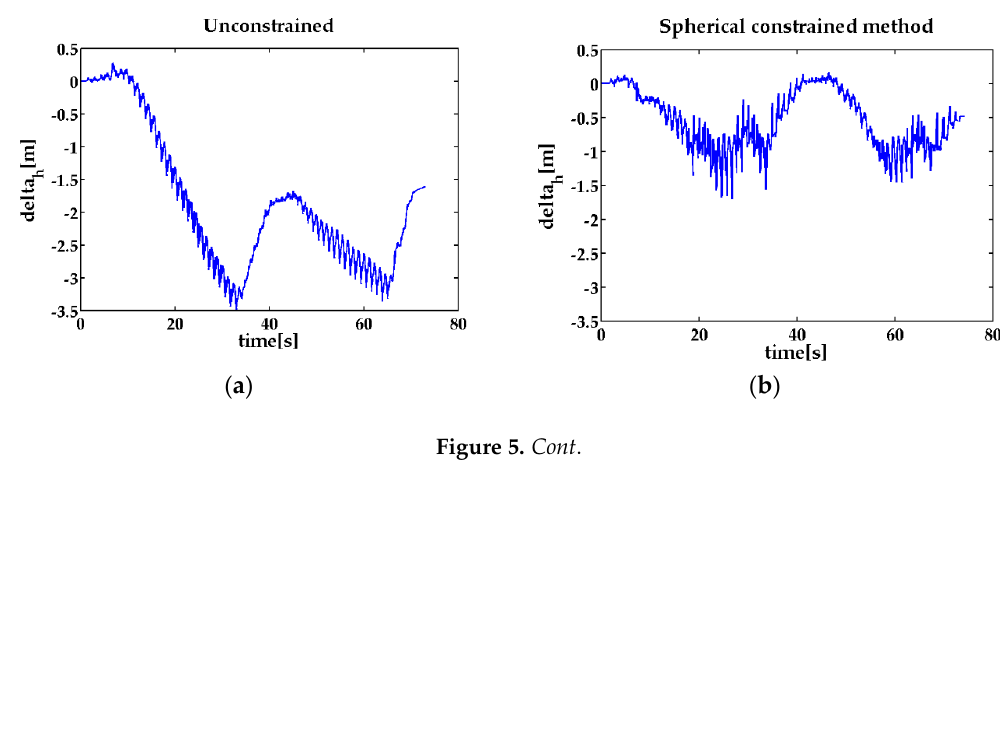
Figure 4. Pedestrian walking a closed path in a corridor outside the laboratory. ( a ) feet trajectories without constraint; ( b ) feet trajectories with spherical constraint; ( c ) feet trajectories with ellipsoidal constraint.